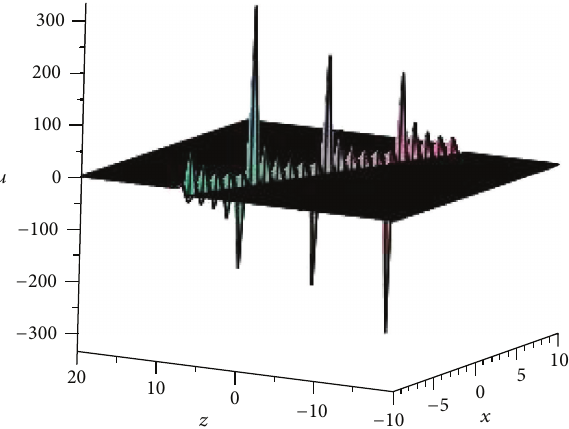
Figure 4: The shape of the 1-positon of first-order to (1) with 𝜆 1 = = 0 . 1.5 , 𝑦 = 0 , 𝑡 = 1 , 𝛾 3